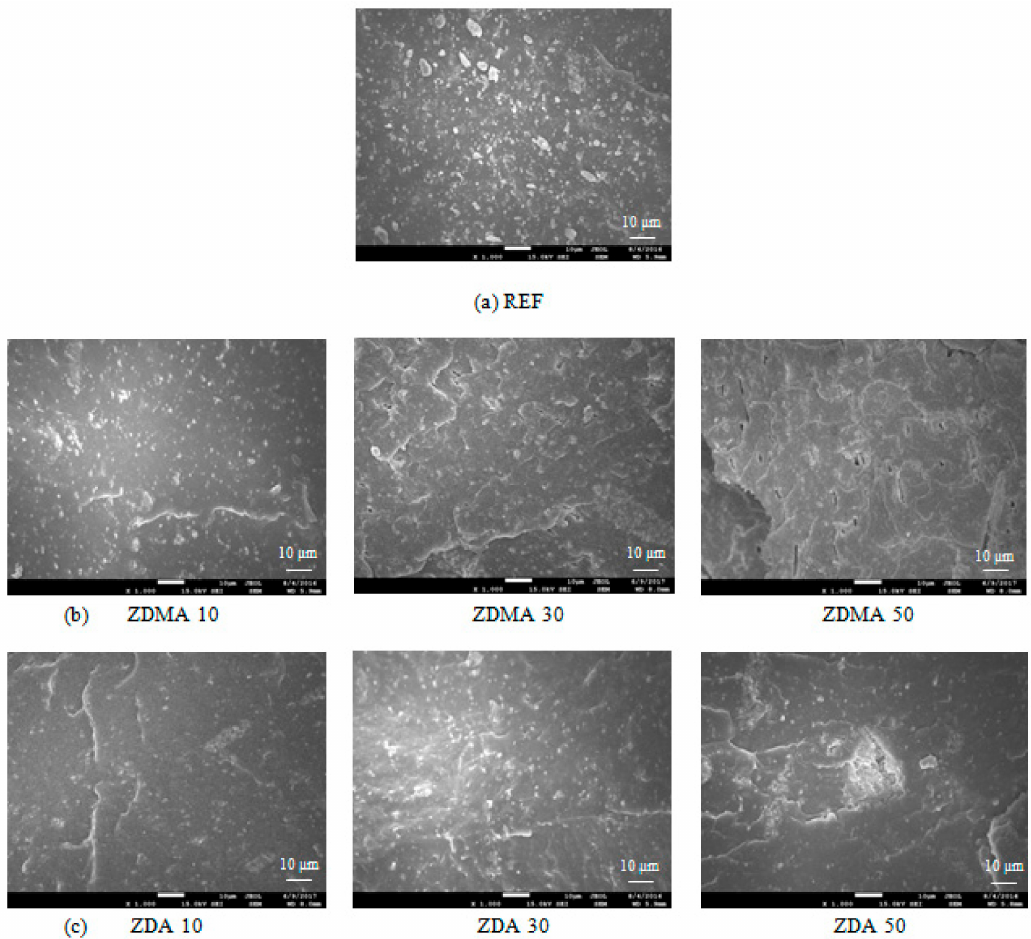
Figure 8. SEM images of composites: ( a ) reference composite cured only with peroxide; ( b ) composites cured with peroxide and zinc methacrylate; and, ( c ) composites cured with peroxide and zinc